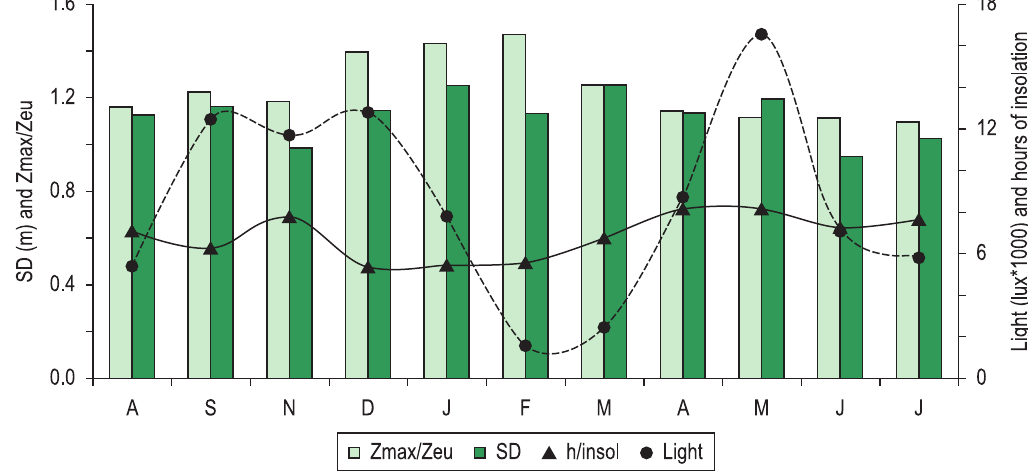
Figure 5. Fluctuations of Secchi disk transparency (SD), light intensities at the water surface, hours of insolation, and Zmax/Zeu, from August 1998 to July 1999.